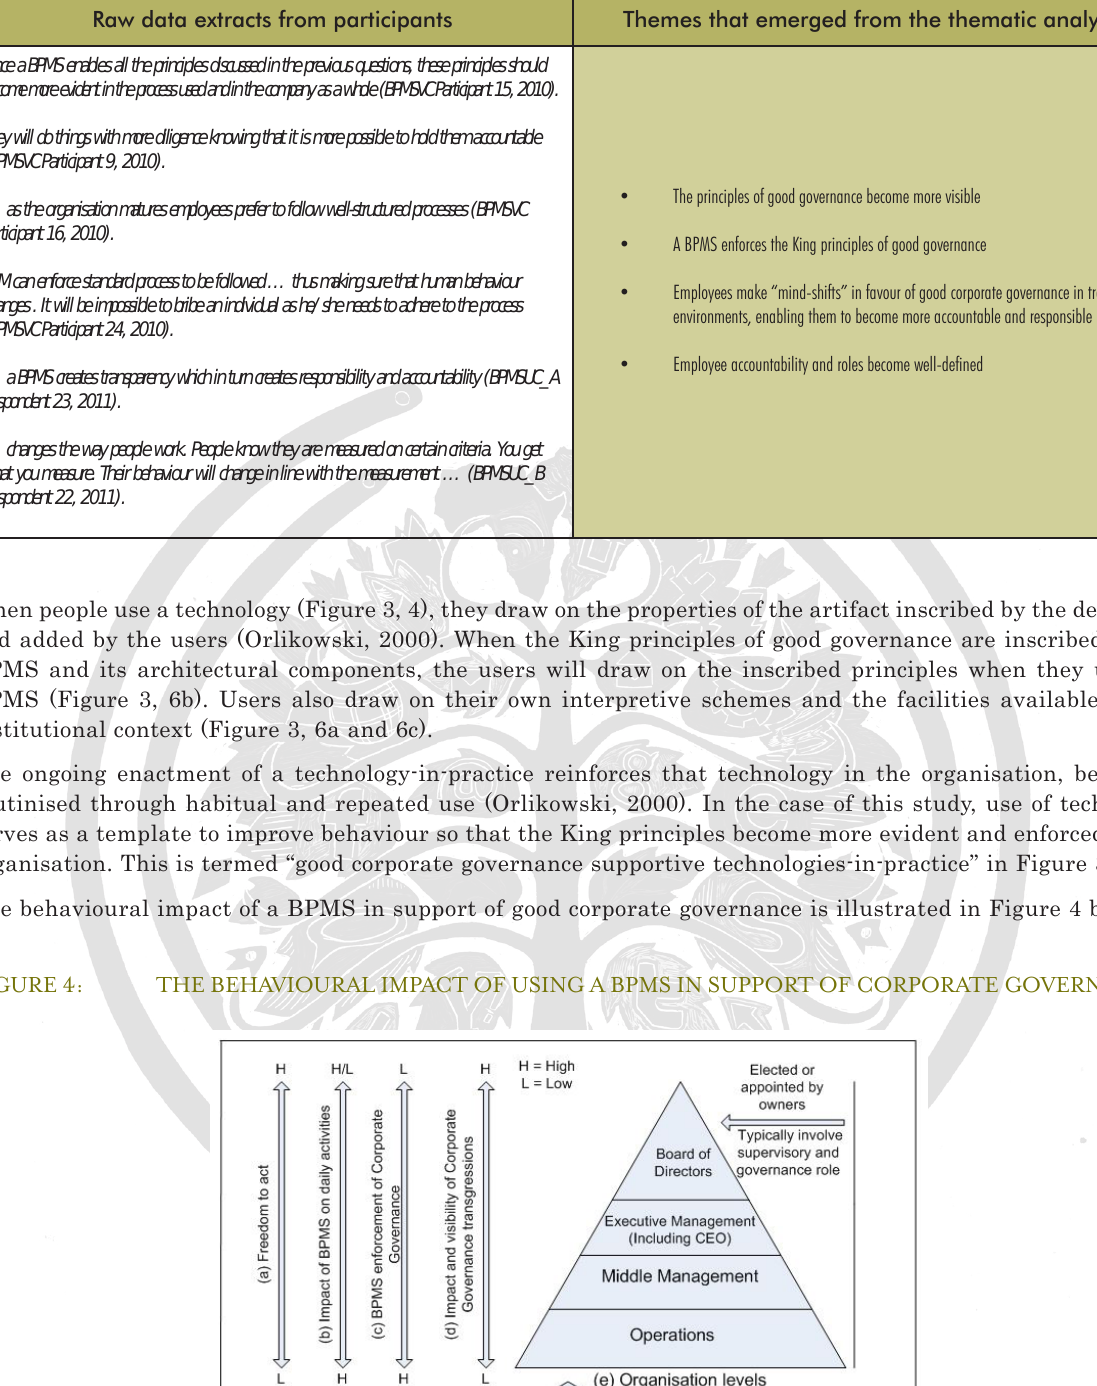
TABLE 3: CHANGING ORGANISATIONAL BEHAVIOUR IN SUPPORT OF CORPORATE GOVERNANCE Raw data extracts from participants Themes that emerged from the thematic analysis